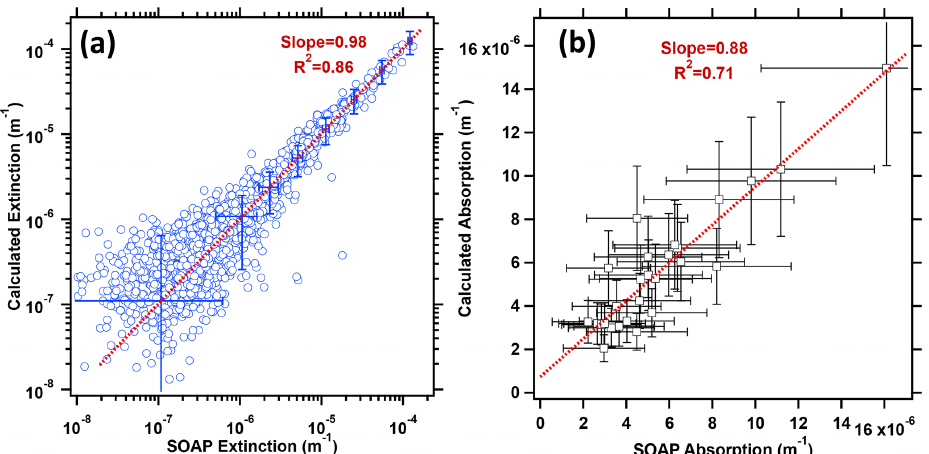
Figure 4. (a) Calculated aerosol extinction as a function of measured extinction from the SOAP cavity ring-down spectrometer during ATom-4, showing representative error bars. (b) As in (a) , but for calculated aerosol absorption and measured absorption from the SOAP photoacoustic spectrometer for cases when absorption > 2 × 10 − 6 m − 1 (2 × the detection limit). Lines and slopes are from two-sided (or- thogonal distance) linear regressions accounting for uncertainties; r 2 values are from one-sided fits. The fitted line in (a) was determined from logarithmically transformed data (log (y) vs. log (x)